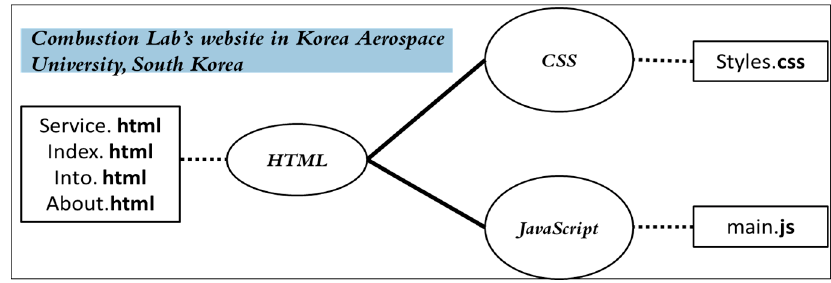
Figure 11. Model, view, and controller (MVC) development architecture: overview and information flow modelling via graphs.